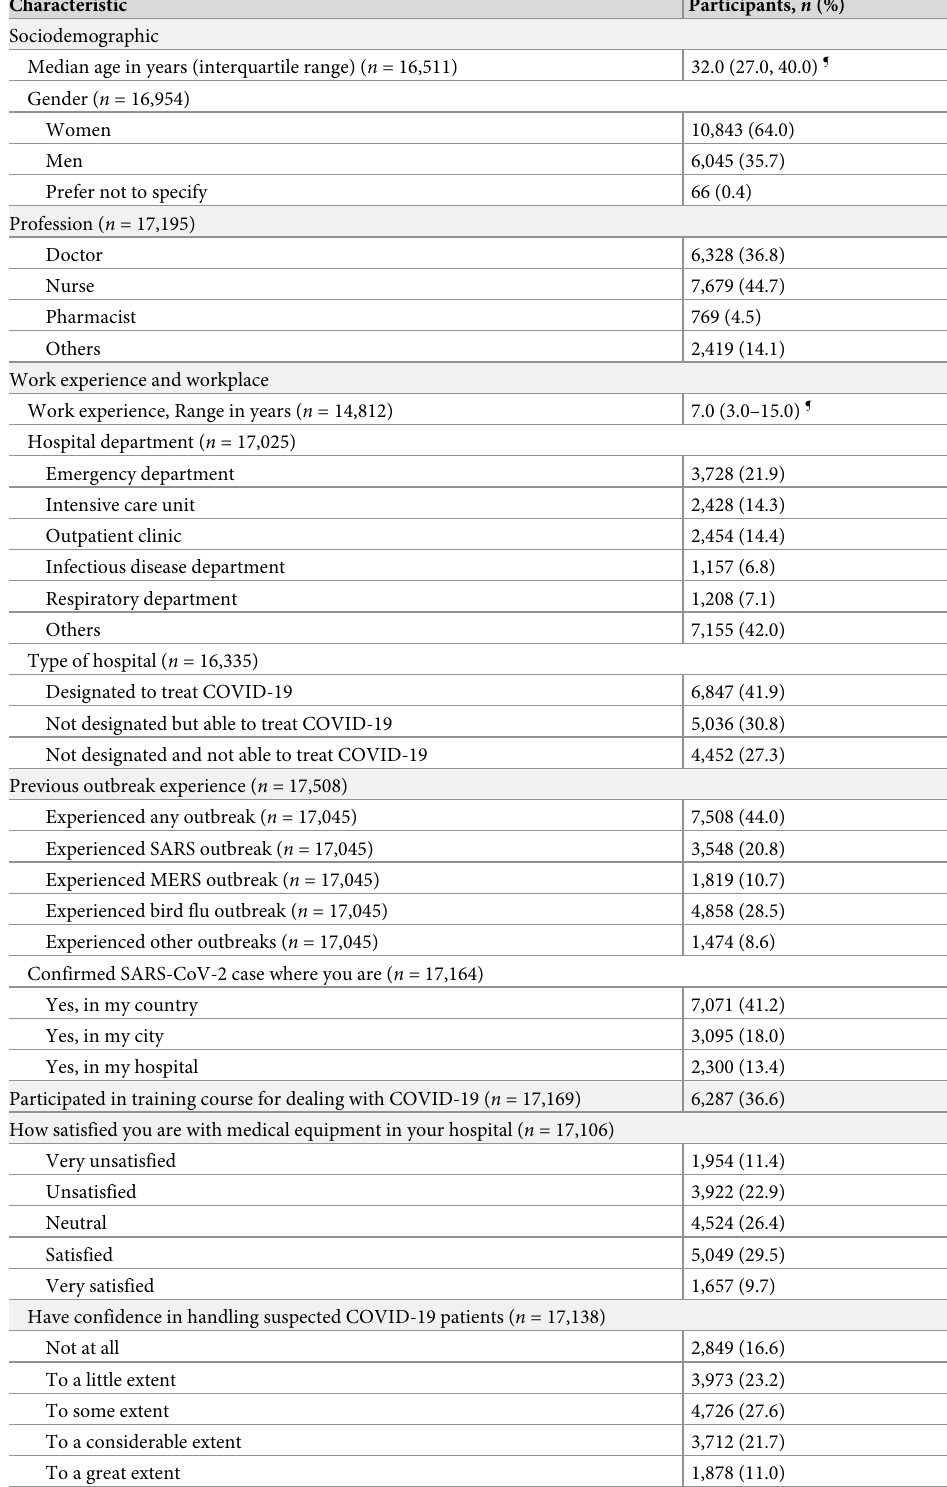
Table 1. Sociodemographic characteristics, work experience, and workplace of participating healthcare